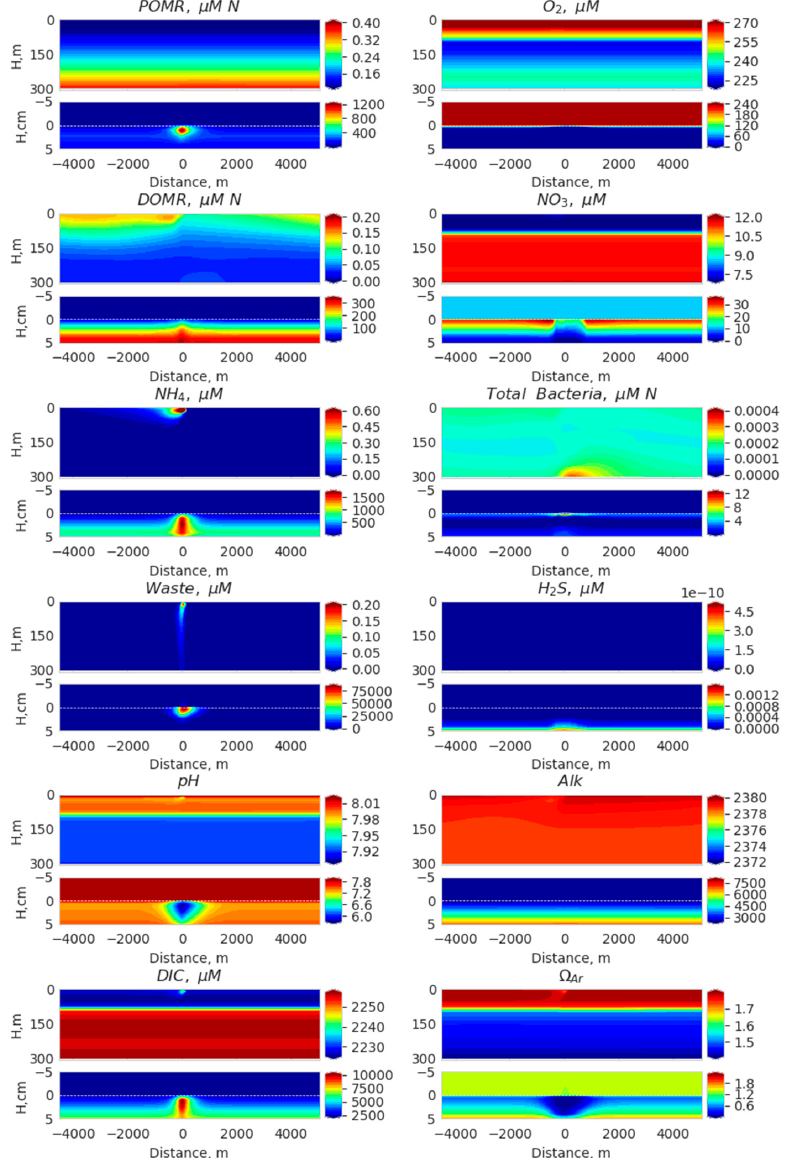
Figure 9. Modeled distributions of selected biogeochemical variables: Particulate semi-labile organic matter (POMR), dissolved semi-labile organic matter (DOMR), ammonium (NH 4 ), waste, pH, dissolved inorganic carbon (DIC), oxygen (O 2 ), nitrate (NO 3 ), total bacteria, hydrogen sulfide (H 2 S), alkalinity (Alk), aragonite saturation ( Ω Ar ) along a transect through the fish farm, 400 days after the onset of farming activities.